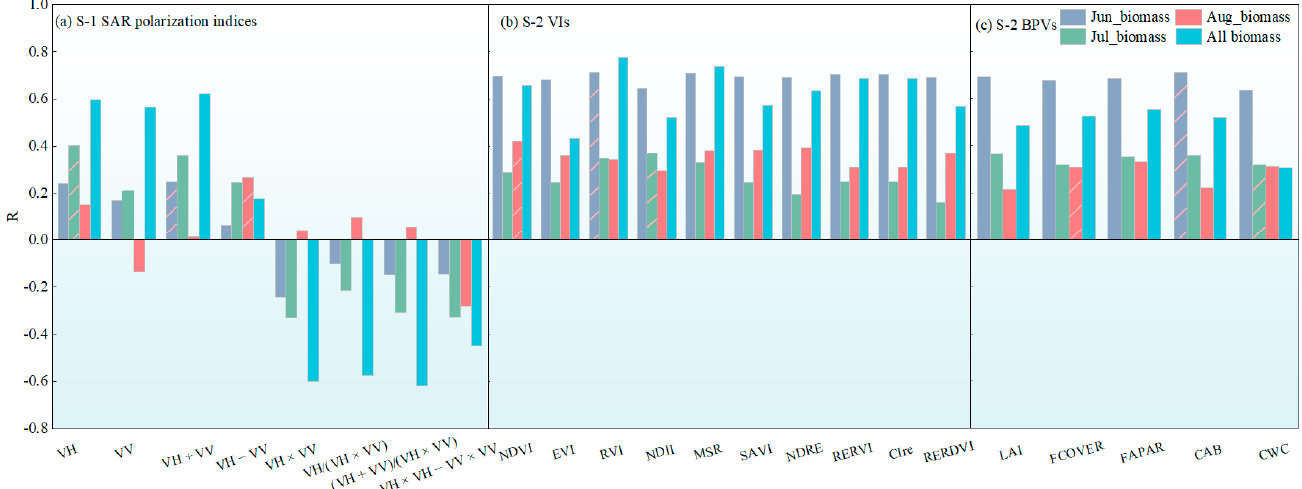
Figure 6. Pearson’s correlation coefficients of different groups of input predictors and maize biomass measured in June, July and August 2018. The bars filled with diagonal lines were the most correlative to biomass of each month.